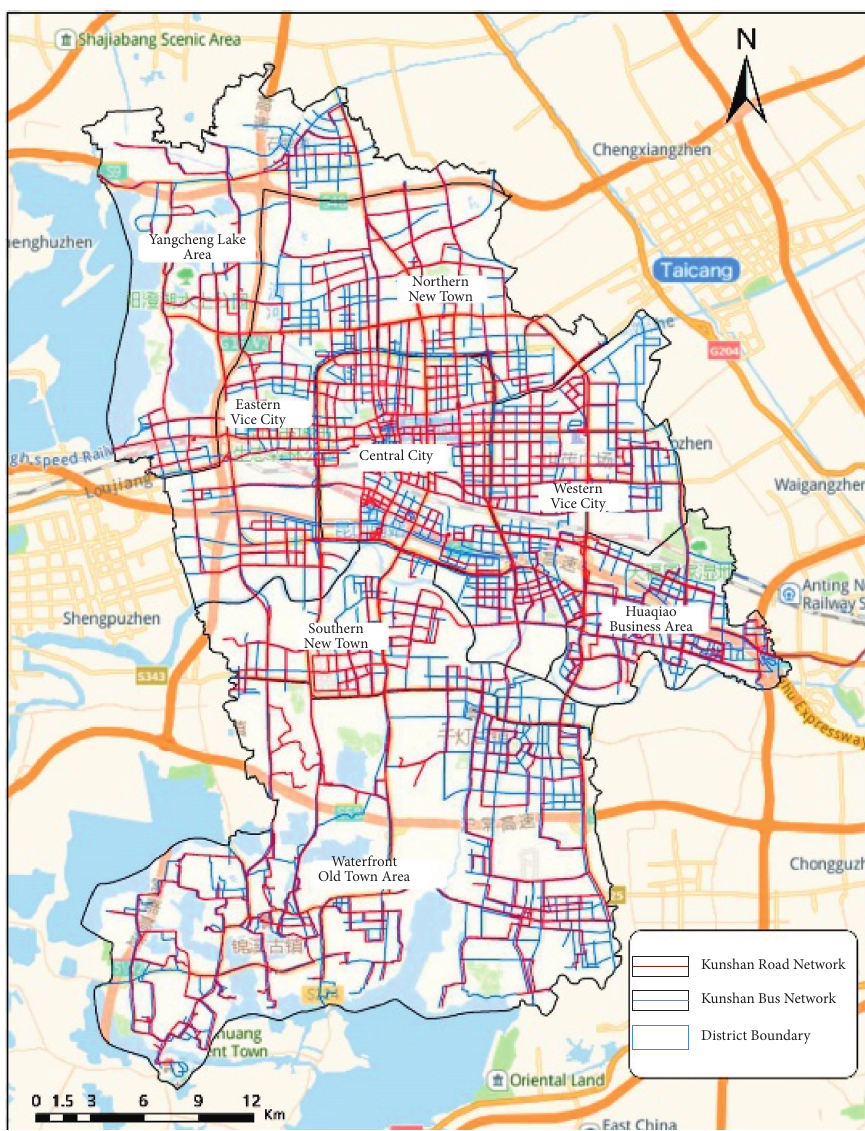
Figure 5: Distribution of road network and bus line network.